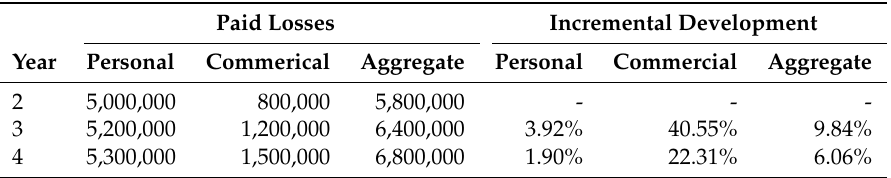
Table 2. An illustrative example of heterogeneity among business